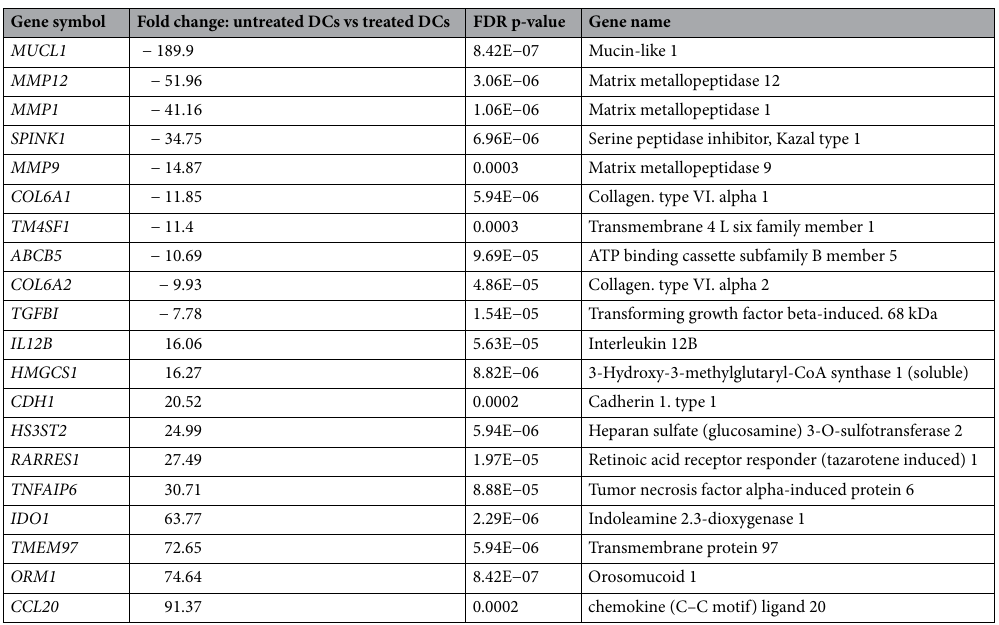
Table 2. Ten most differentially expressed genes between mDCs treated with EVs and untreated mDCs. Negative numbers: up regulation in treated mDCs. The p value was FDR